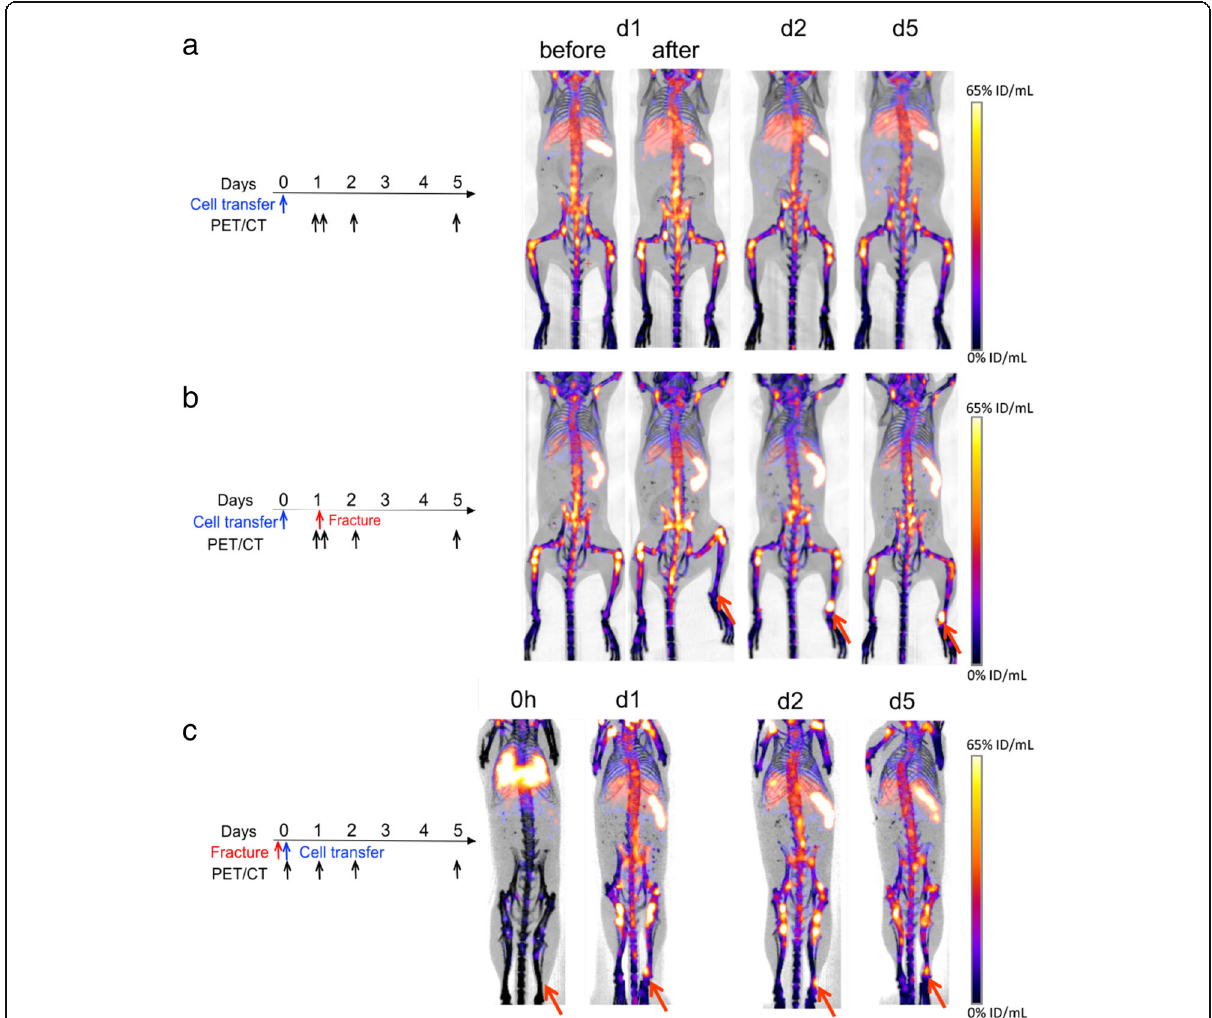
Fig. 1 BM cells labeled with 89 Zr-oxine rapidly accumulate at the bone fracture. a The regimen of BM cell transfer and microPET/CT imaging in control mice and acquired images is shown. The 89 Zr-oxine-labeled BM cells (2 – 2.3×10 7 cells at 9.65 – 15.7 kBq/10 6 cells) administered intravenously homed to the BM, spleen, and liver by day 1 and remained in these organs until day 5 ( n =4). b The day 1-tibial fracture scheme and acquired microPET/ CT images are shown. The 89 Zr-oxine-labeled BM cells distributed to the BM, spleen, and liver by day 1 as in the control mice. Following the tibial injury, labeled cells migrated to the fracture with peak accumulation by day 2, extending through day 5 ( n =4). c The day 0-tibial fracture scheme and acquired microPET/CT images are shown. The 89 Zr-oxine-labeled BM cells transferred immediately after the fracture generation trafficked to the injury site and remained at the site until day 5 ( n